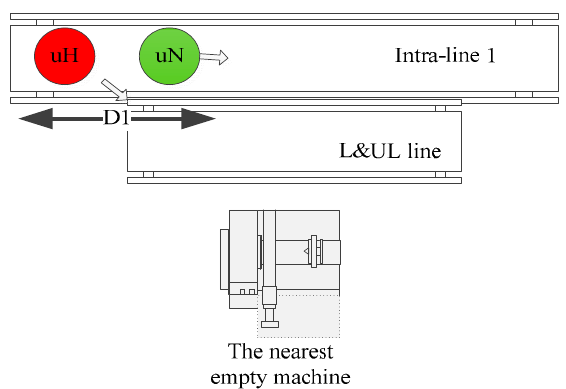
Figure 5. The unprocessed hot lot (uH) first (Rule 1).